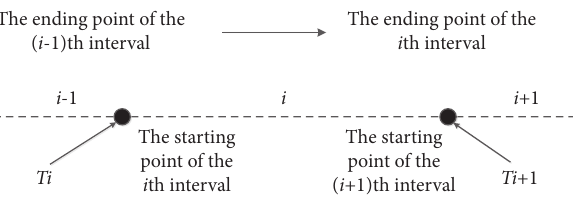
Figure 1: Methodology framework.